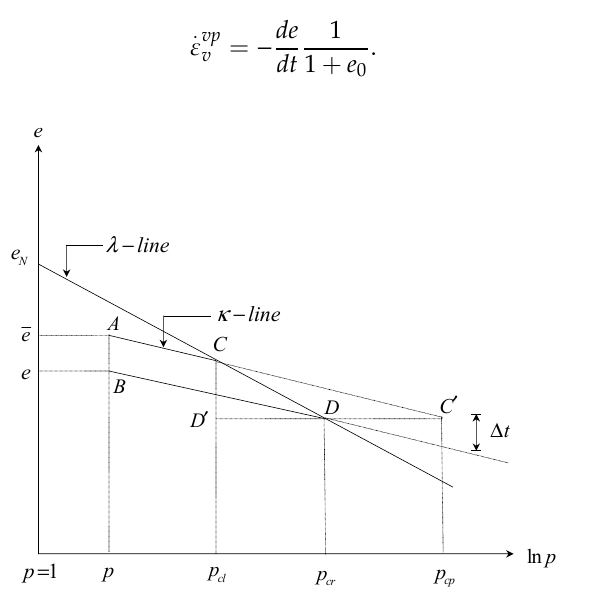
Figure A1. Undrained triaxial test path for the virgin consolidated clay for the normal consolidation line and the swelling consolidation line representing the initial surfaces.